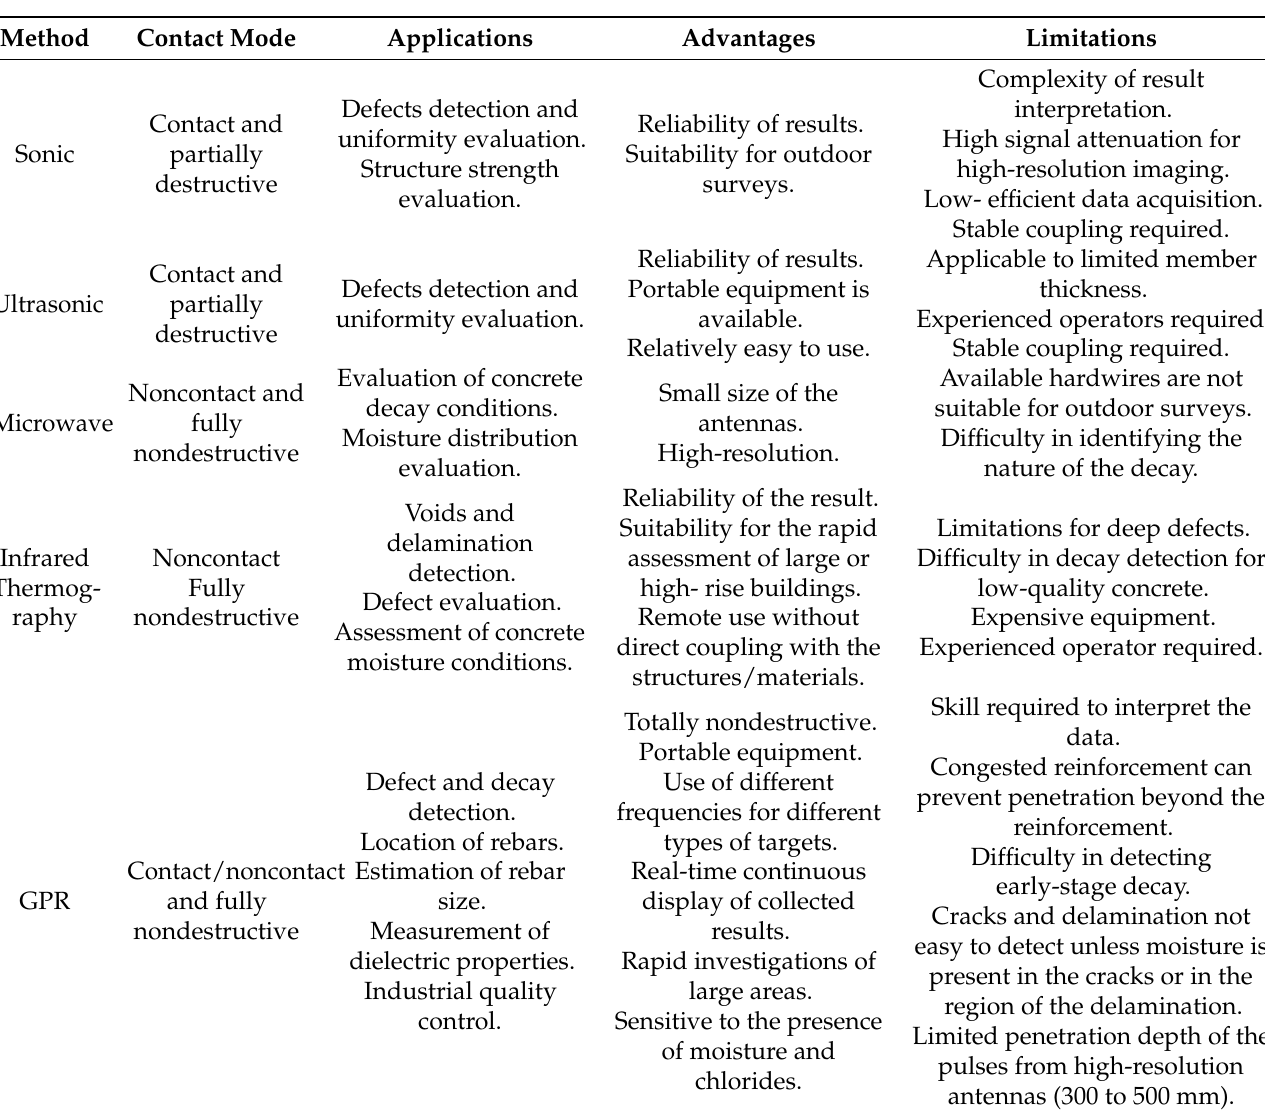
Table 4. The main NDT methods for the investigation of concrete and reinforced concrete materials and structures according to